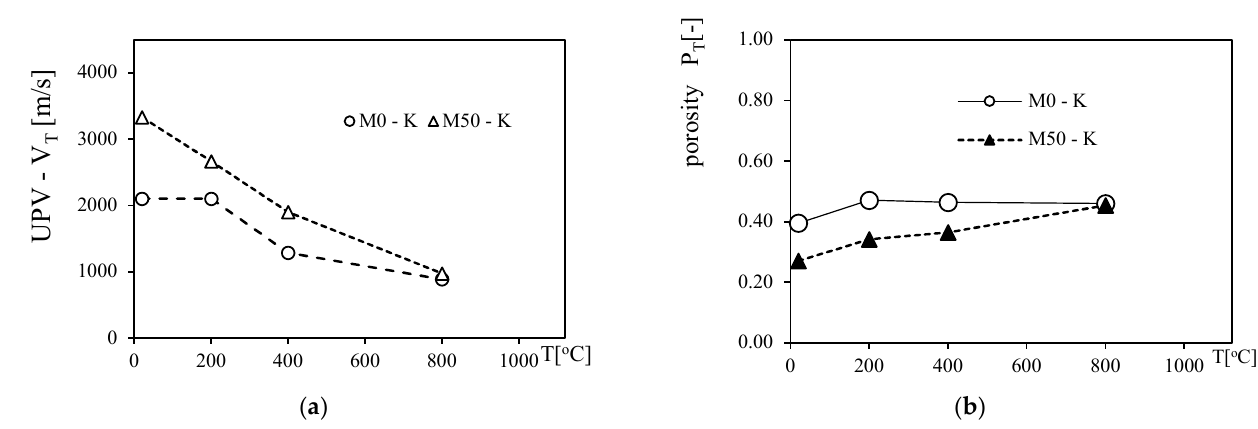
Figure 5. ( a ) Ultrasound Pulse Velocity (UPV—V T ) and ( b ) porosity (P) with temperature.